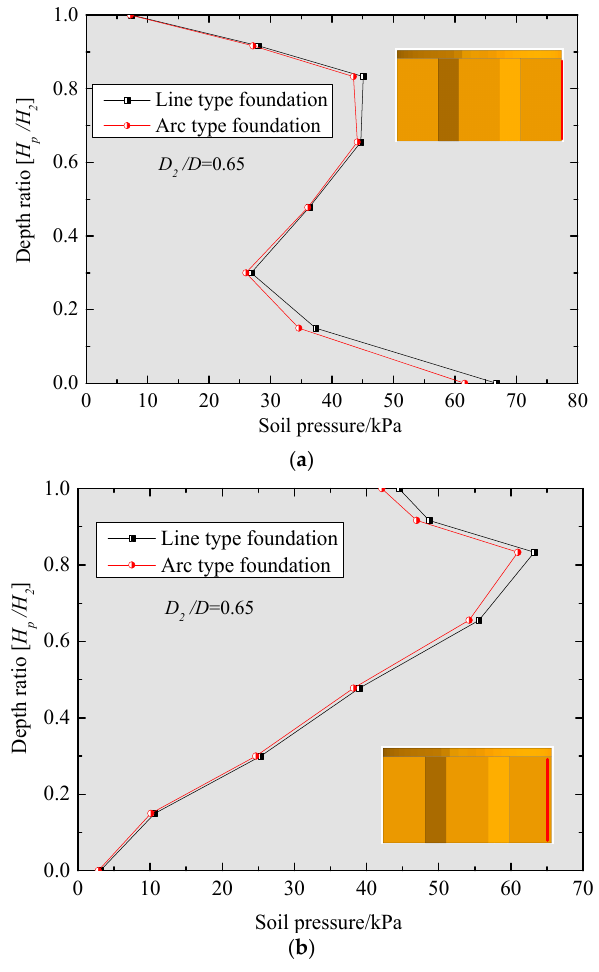
Figure 14. Soil pressures on the front bucket: ( a ) Outside skirt; ( b ) Inside skirt.